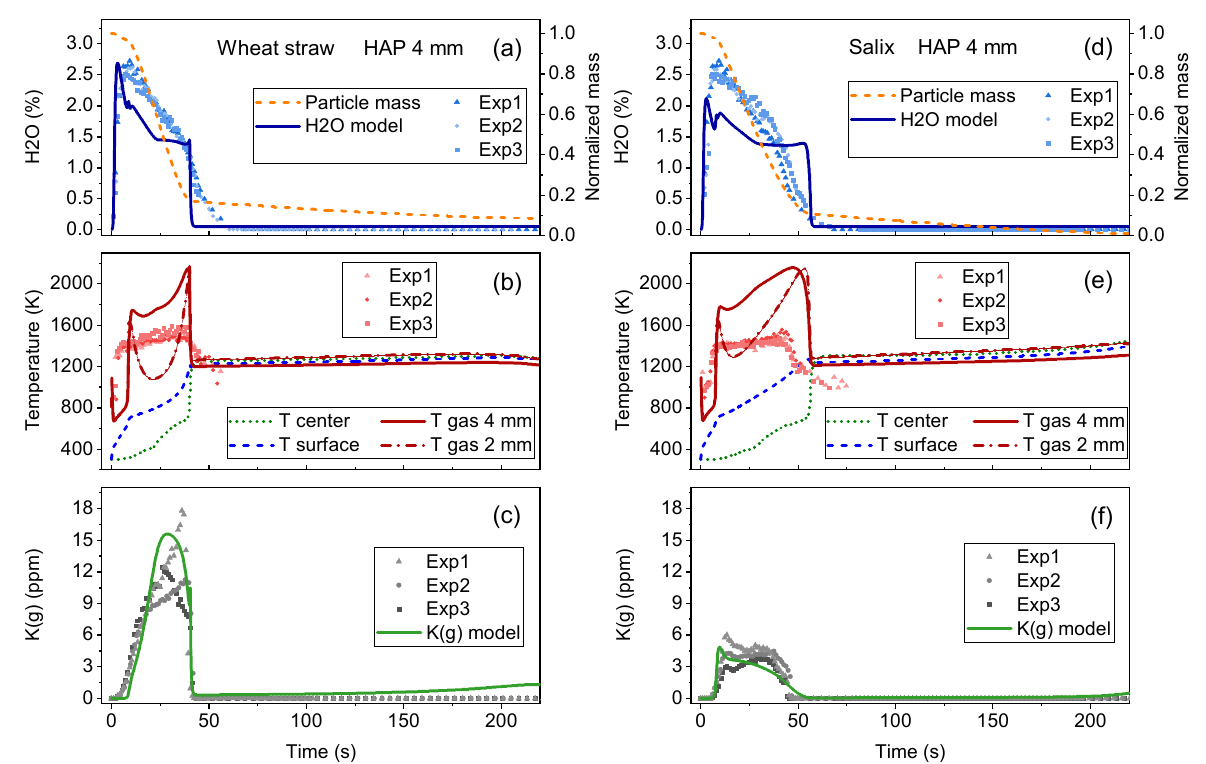
Figure 4. Comparison between measured and simulated H 2 O ( a , d ), temperature ( b , e ) and K(g) ( c , f ) at HAP 4 mm for wheat straw ( a – c ) and Salix ( d – f ). Solid lines represent results obtained by the numerical particle model, whereas markers display TDLAS data.